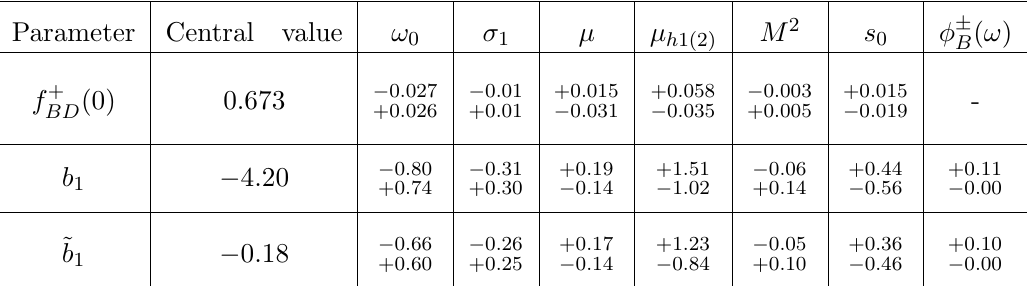
Table 1 . Summary of the predicted shape parameters and the normalization constant entering the z -series parametrizations (5.9) and (5.10) for the B ! D‘(cid:23) form factors with dominant uncertainties from the variations of theory